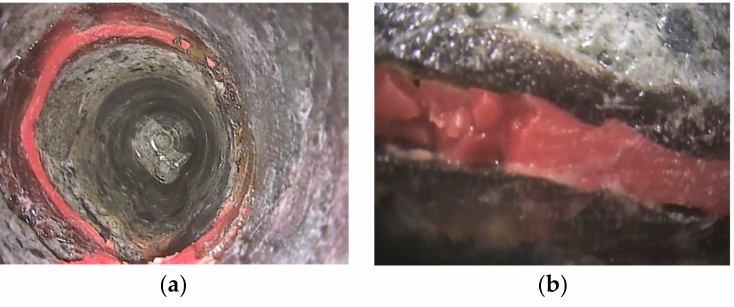
Figure 10. Cracks filled with resin ( a , b ).